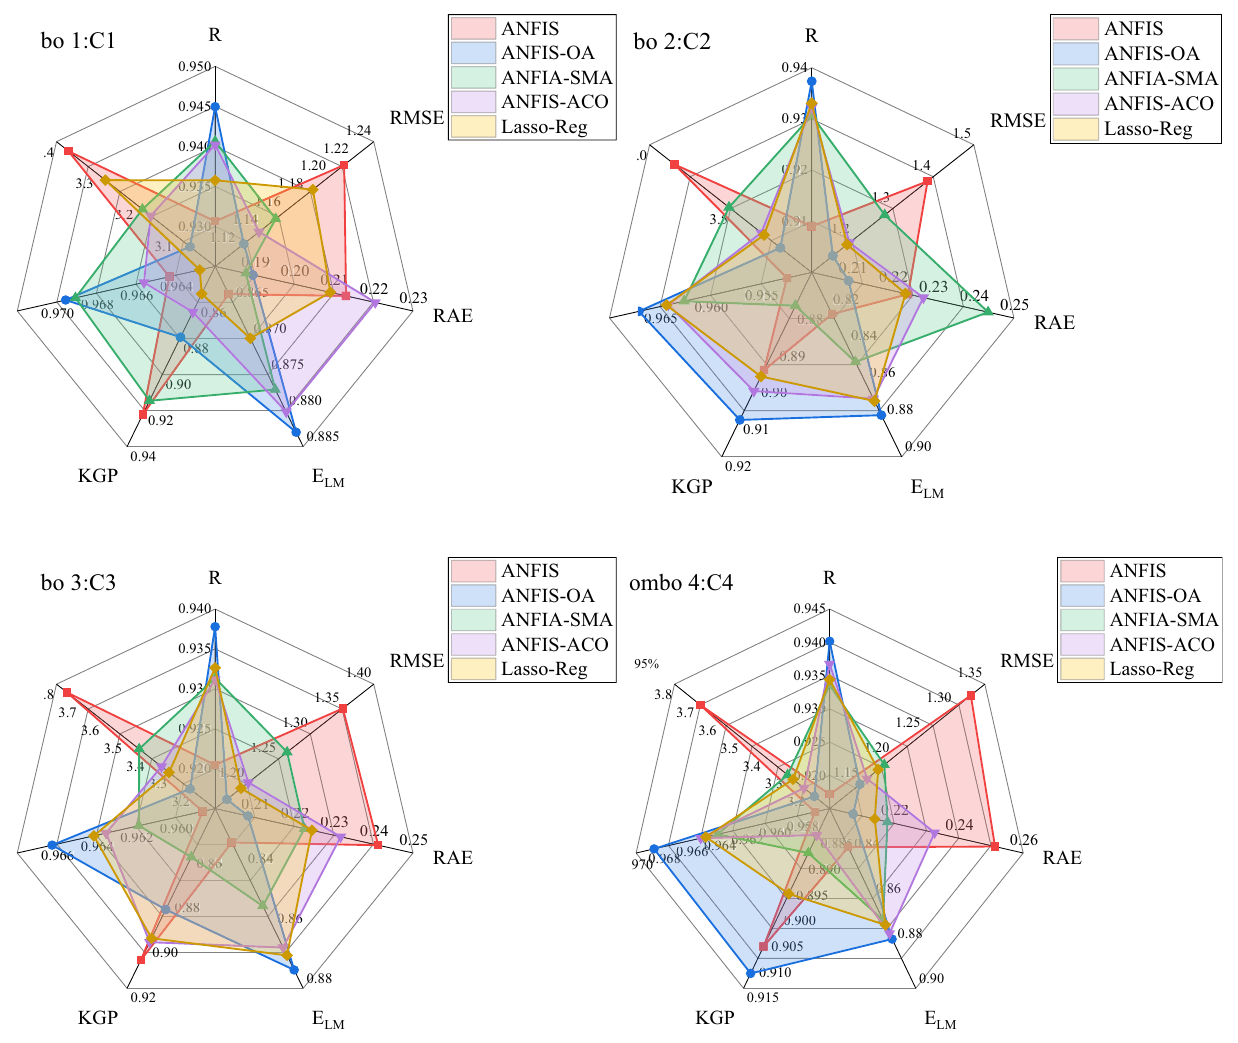
Figure 7. the presentation of spider plot for the developed models and input